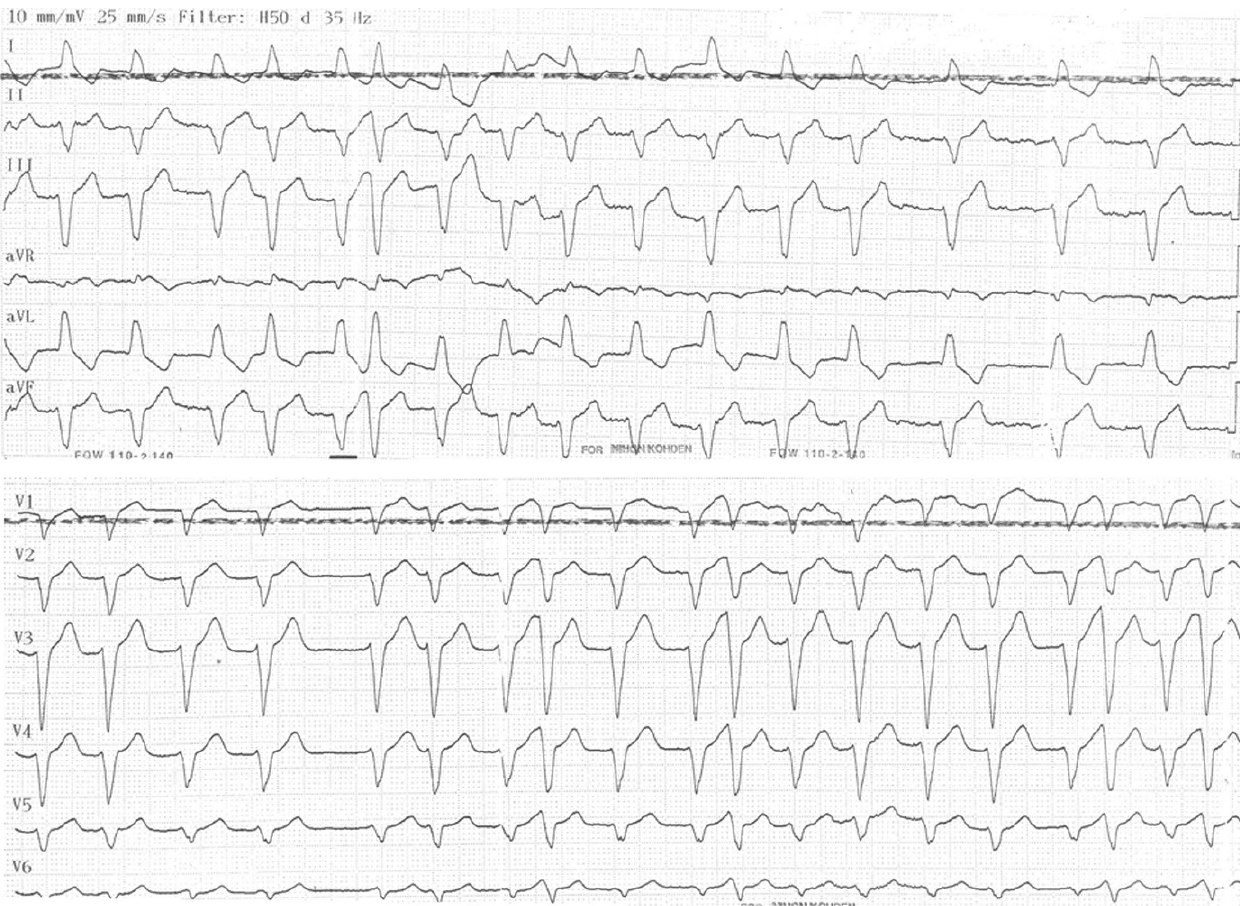
Figure 1 - Paroxysmal atrial fibrillation and intermittent left bundle branch block